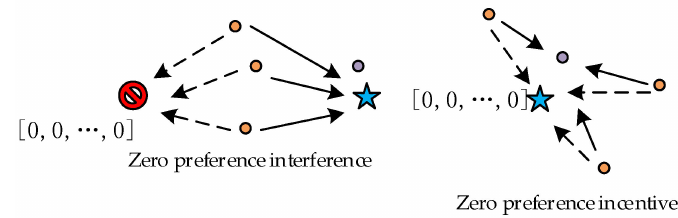
Figure 1. Zero preference interference and